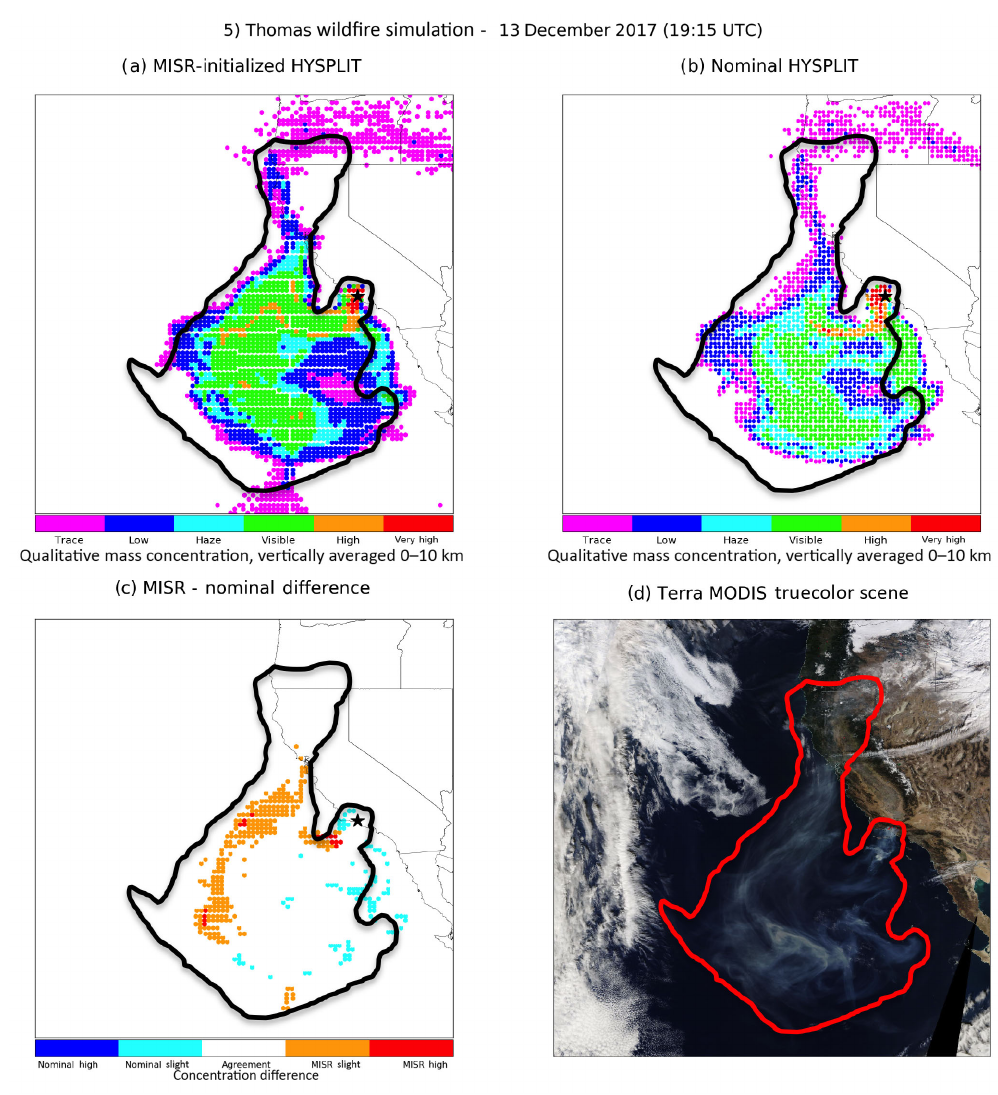
Figure 5. Same as Fig. 2, but for the Thomas fire plume, on 13 December 2017. (a–b) Day 4 samplings of HYSPLIT 96h simulations run with the GDAS 0.5 ◦ meteorology, beginning on 10 December 2017, and (c) Day 4 difference plot. (d) MODIS true-color image acquired on 13 December